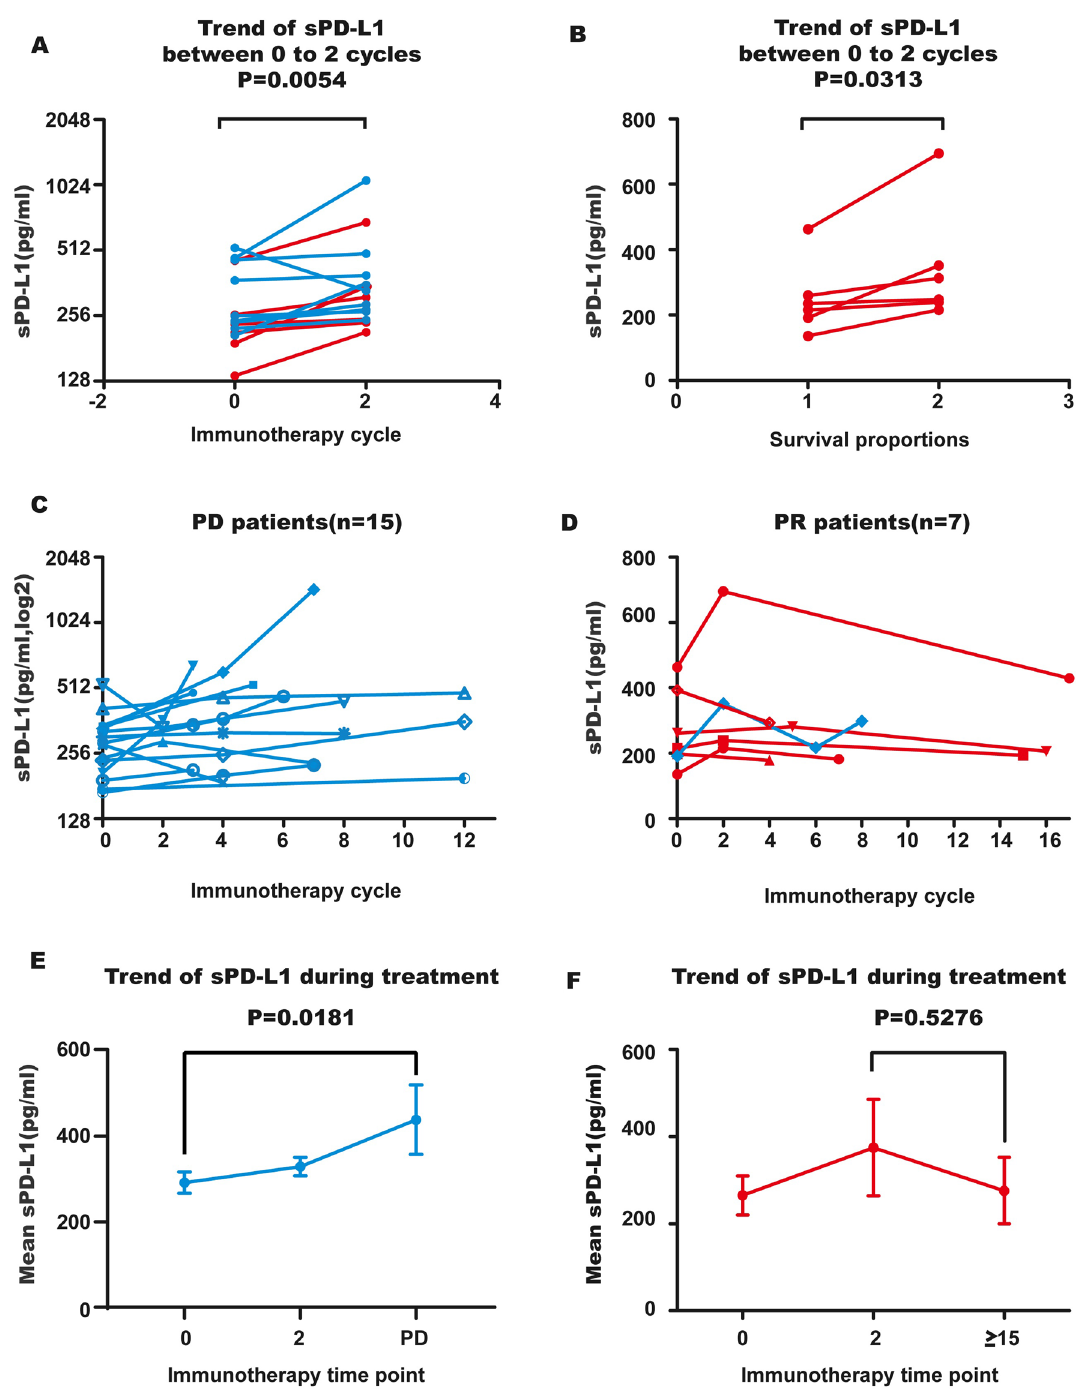
Fig. 3 Dynamic changes in functional sPD-L1 during anti-PD-1 treatment. A Blood functional sPD-L1 was elevated from baseline to 2 cycles (42 days) in NSCLC patients treated with anti-PD-1 antibodies. B Blood functional sPD-L1 was increased from baseline to 2 cycles in PR patients. C , D Dynamic changes in blood functional sPD-L1 in PD (n = 15) and PR (n = 7) patients during anti-PD-1 treatment. Each line repre- sents a patient. E, F Dynamic changes in the mean value of functional sPD-L1 during anti-PD-1 treatment. Functional sPD-L1 was gradually increased in PD patients; in the PR group, sPD-L1 rose first and then declined after 2 cycles of treatment. PD, blue; PR, red. There was one patient in the PR subset (blue line) whose sPD-L1 was increased after 8 cycles of anti-PD-1 treatment (evaluated as PR), and her treatment was changed to anti-PD-1 mAb + bevacizumab at the 19th cycle because of an increase in pleural effusion. The increase in sPD-L1 occurred earlier than did clinical